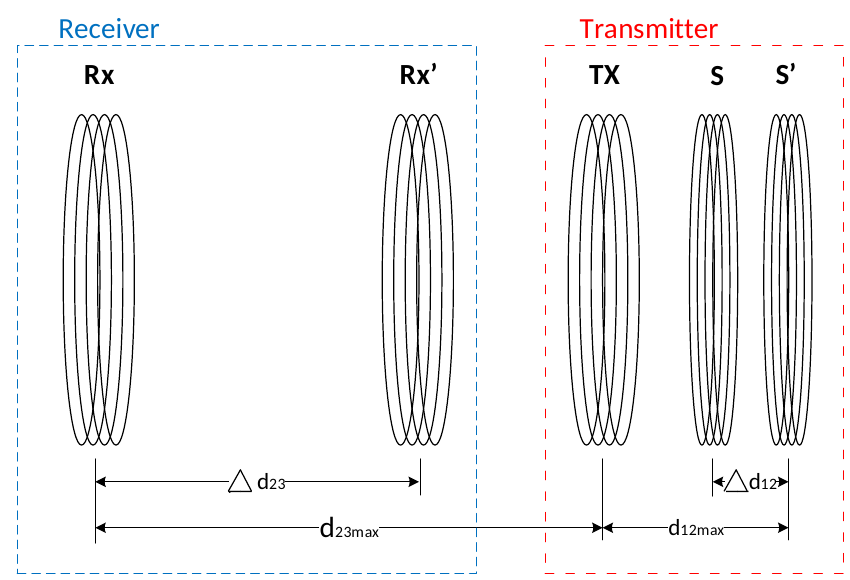
Figure 9. Maximum efficiency measurements setup.